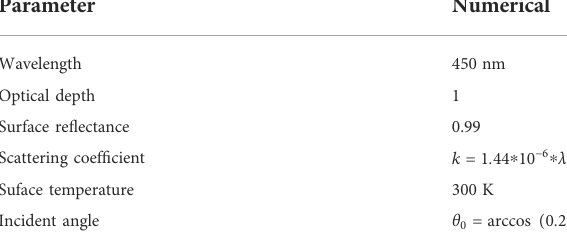
TABLE 1 Simulation model validation